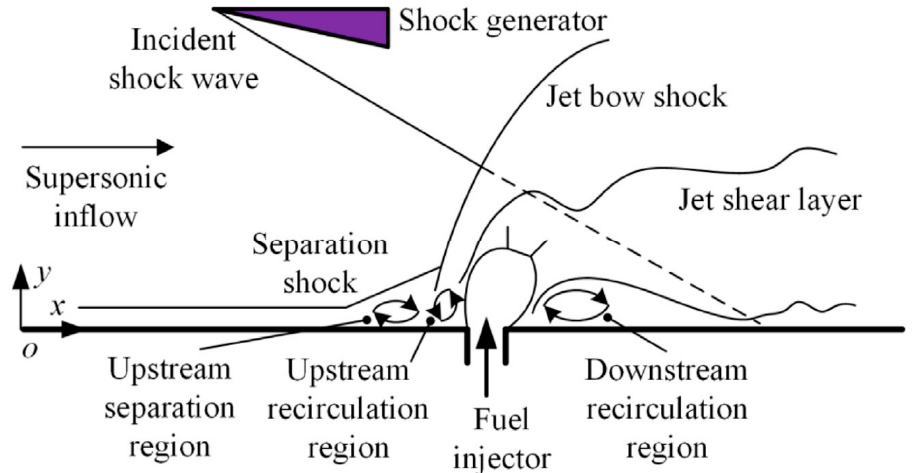
Figure 1. Flow field structure of the shock wave/jet shear layer interaction for transverse injection in the supersonic crossflow [7].